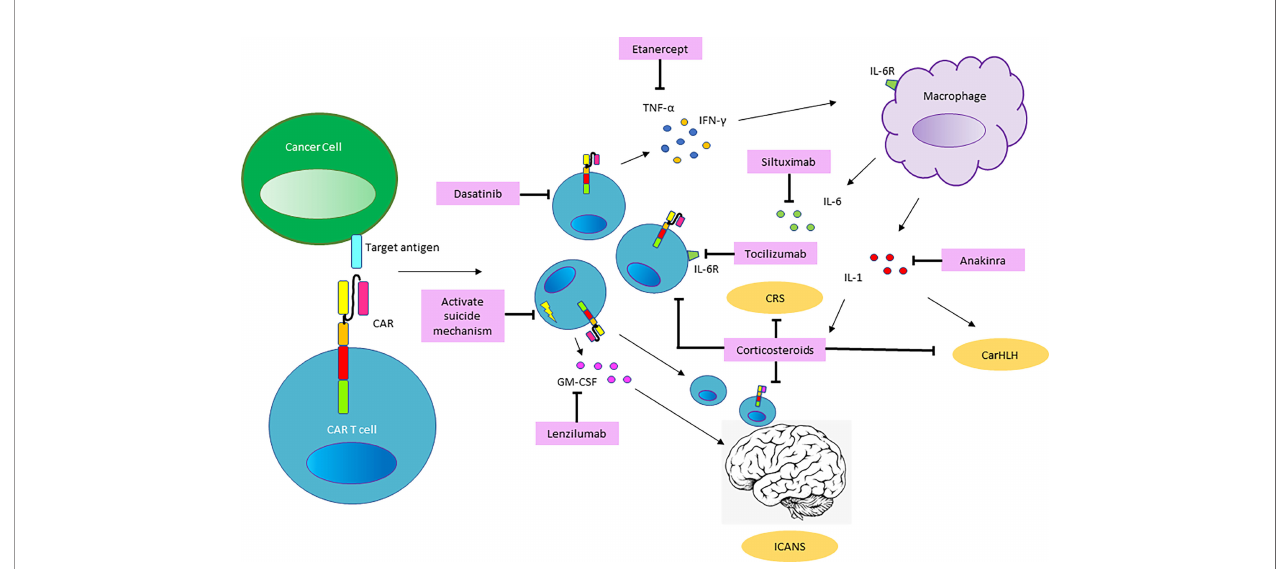
FIGURE 2 | Mechanisms of Toxicity and Pathways for Intervention. Based on our current understanding of the pathophysiology involved in CART cell mediated toxicities, CART cells proliferate and produce in fl ammatory cytokines such as granulocyte-macrophage colony-stimulating factor (GM-CSF), interferon- g (IFN g ), tumor necrosis factor- a (TNF a ) and other soluble in fl ammatory mediators, upon recognition of the CAR-target antigen. This results in monocyte recruitment and activation of macrophages, which serve as the major source of Interleukin-6 (IL6) and Interleukin-1 (IL1), driving the systemic pathology of CRS. Penetration of cytokines and migration of CART cell and endogenous T cells into the CNS promote the development of ICANS. Shown in pink boxes are therapeutic tools for intervention in the pathways involved in CART-related toxicities. Blockade of the IL6-receptor (IL6R) by the monoclonal antibody (mAb) targeting the IL6R, Tocilizumab and the use of corticosteroids are well established in the management of CRS. Siltuximab, a mAb targeting IL6 may serve as an alternative agent to intervene in the IL6 pathway. The IL1-receptor (IL1R) antagonist Anakinra is emerging as a tool to preempt and treat CRS and has been utilized to treat CarHLH. The use of the TNF-antagonist Etanercept and GM-CSF antagonist Lenzilumab is not clinically established but may represent a therapeutic option based on the pathways involved. Preclinical data suggests that the kinase inhibitor Dasatinib may have a role in inhibiting CART cells and CART-mediated cytokine production. In CART cell constructs equipped with a suicide mechanism, pharmacologic activation of the suicide switch or mAb-based targeting of surface proteins included in the CART construct may be utilized to abrogate CART cell function in the setting of severe toxicity.